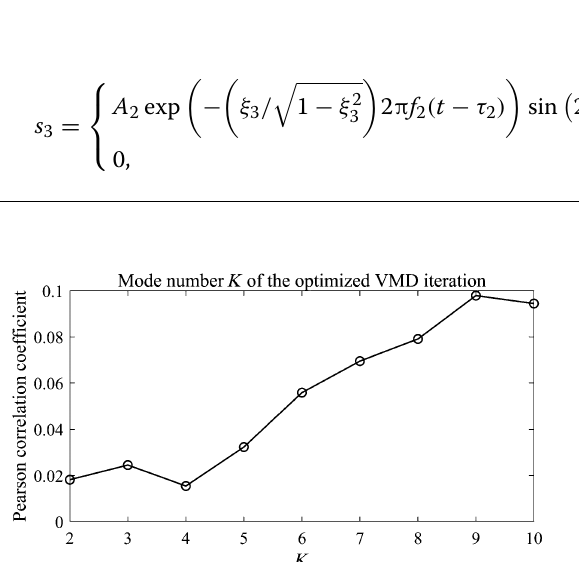
Figure 5 Mode number K of the Optimized VMD iteration